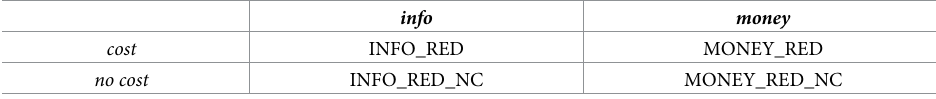
Table 6. Treatments of reduced question set experiment.